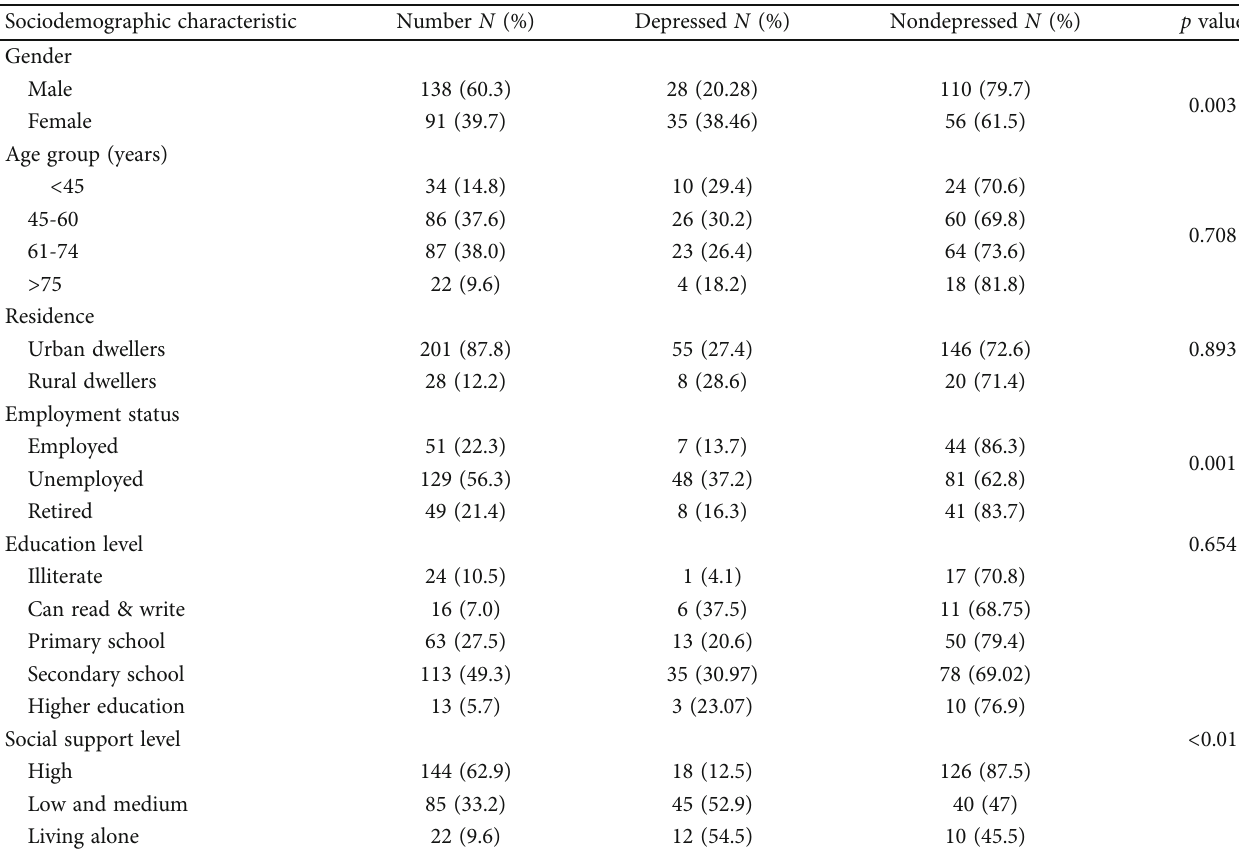
Table 1: Distribution and chi-squared tests of PSD in relation to some sociodemographic characteristics of study respondents at